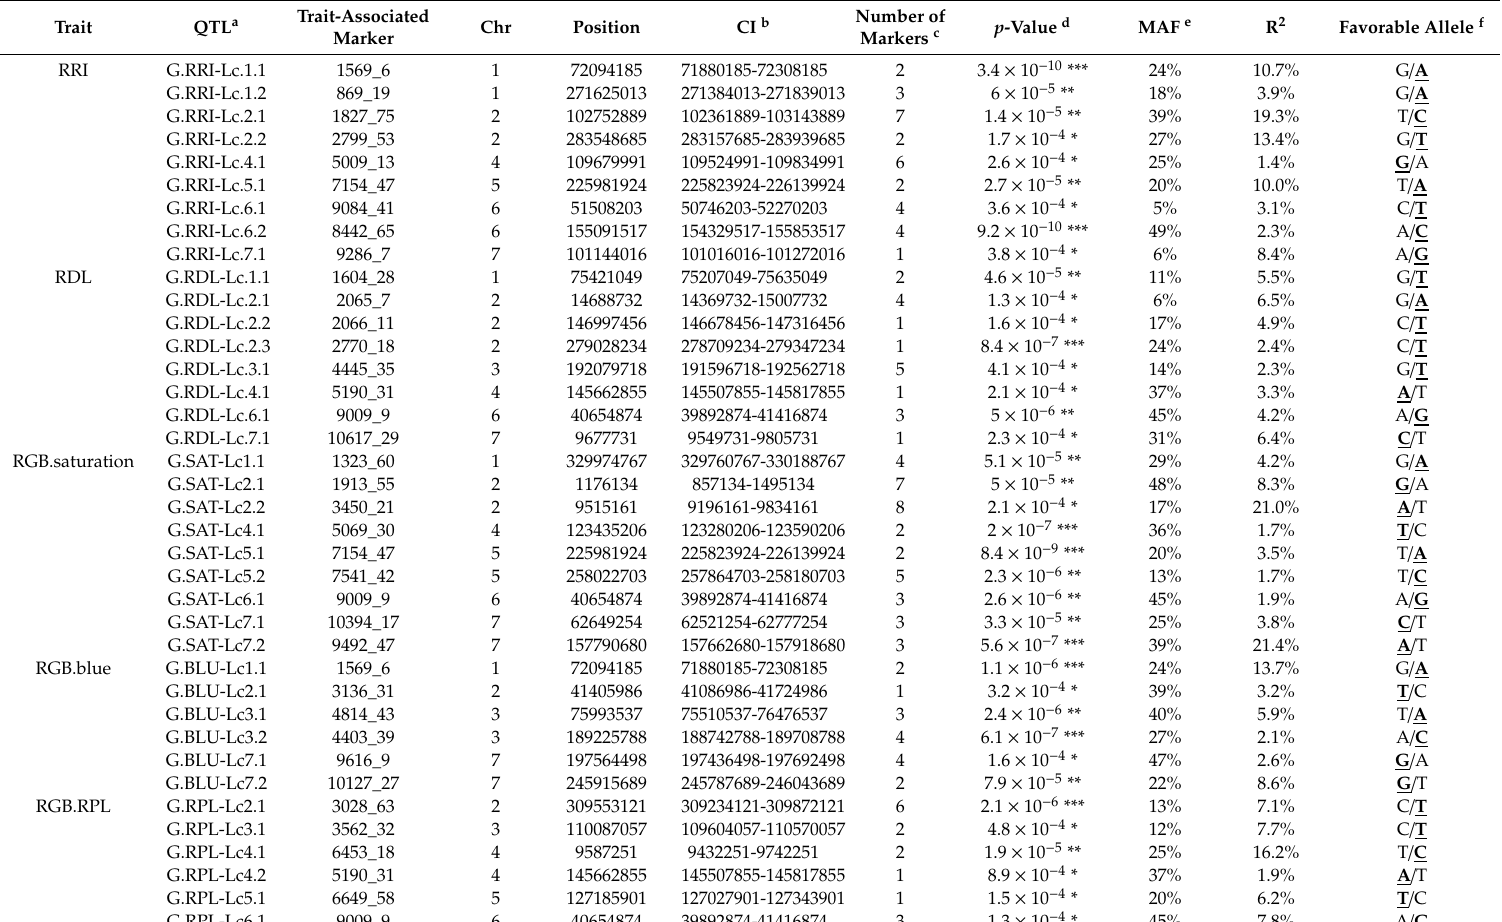
Table 3. QTL for the ARR resistance traits in the association mapping